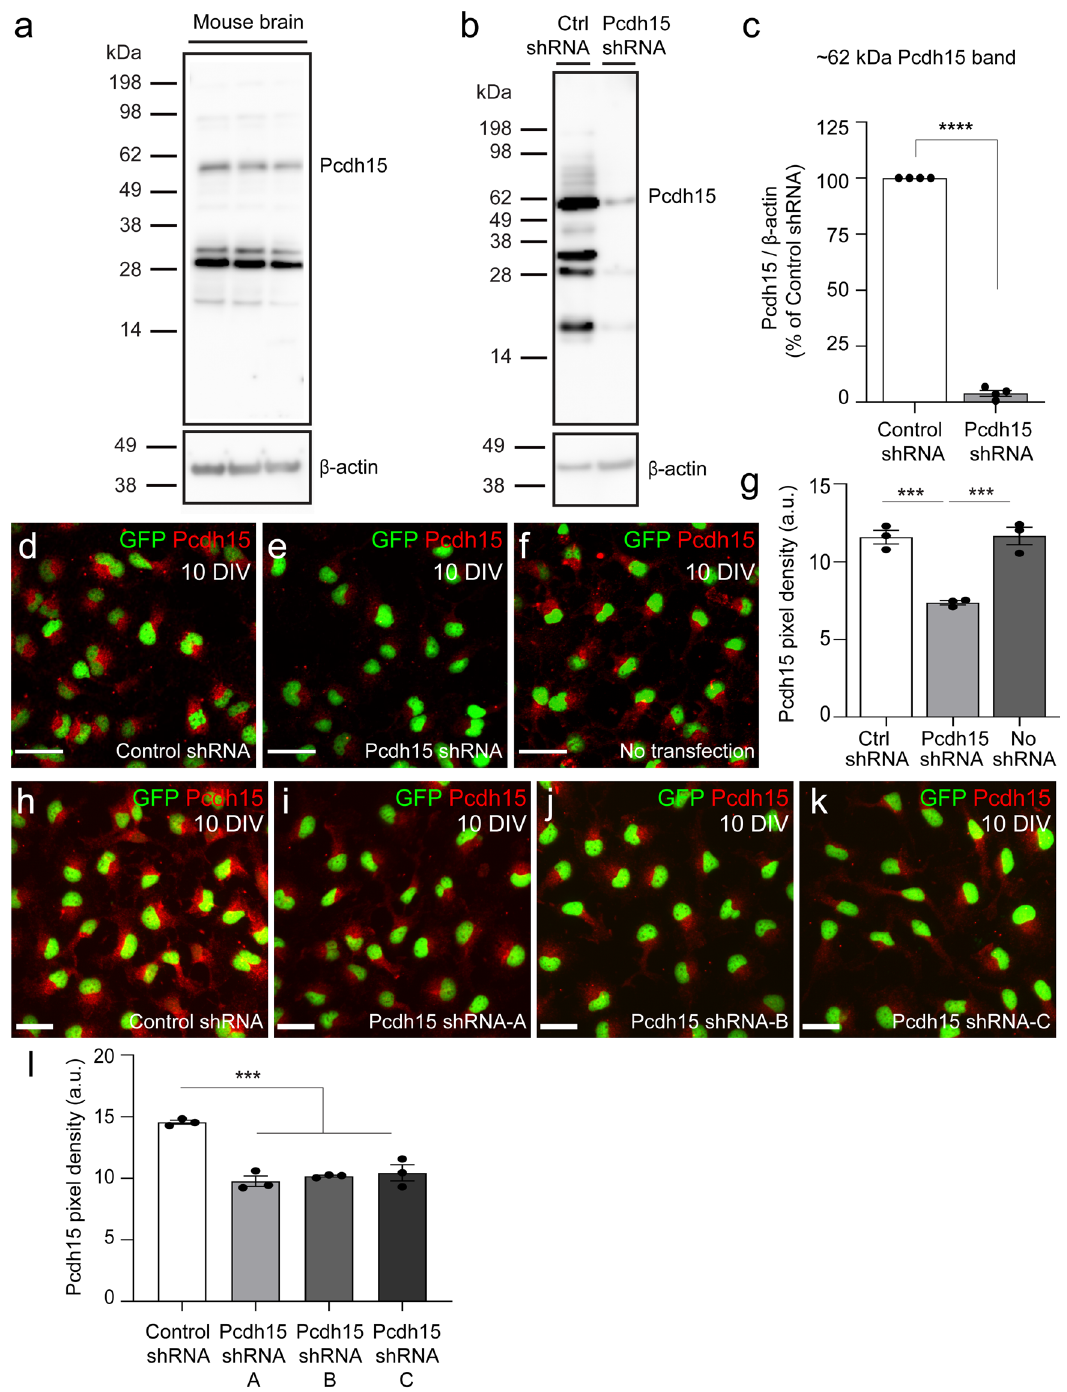
data are consistent with Pcdh15 acting as a negative regulator of OPC proliferation in